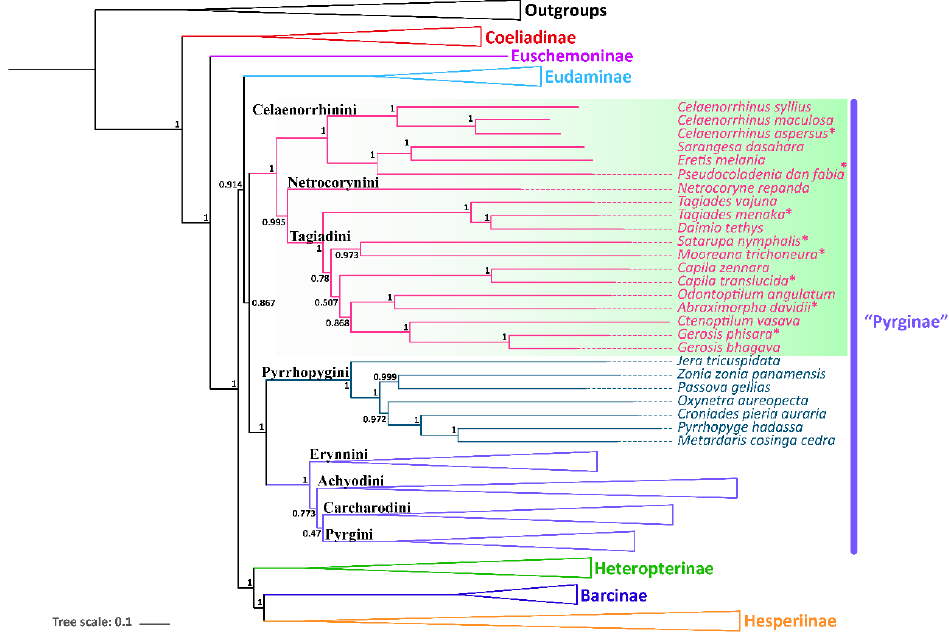
Figure 4. Phylogenetic tree produced by Mrbayes of PRT dataset. * indicates the materials added in this